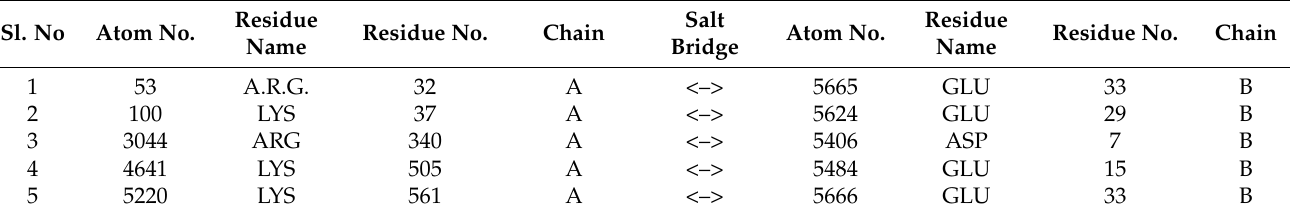
Table 5. Salt bridges between Chain A (TLR2) and Chain B (Vaccine) of TLR2–vaccine